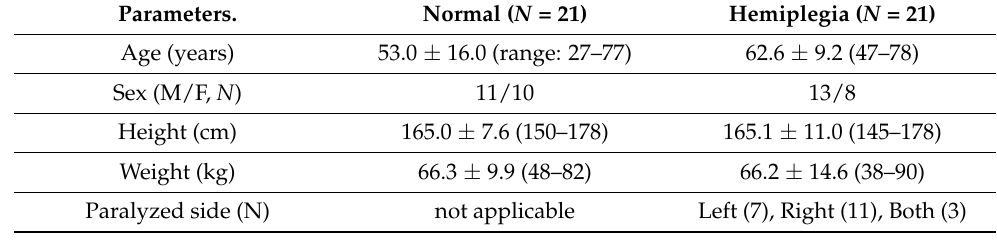
Table 1. Demographic information for participants.